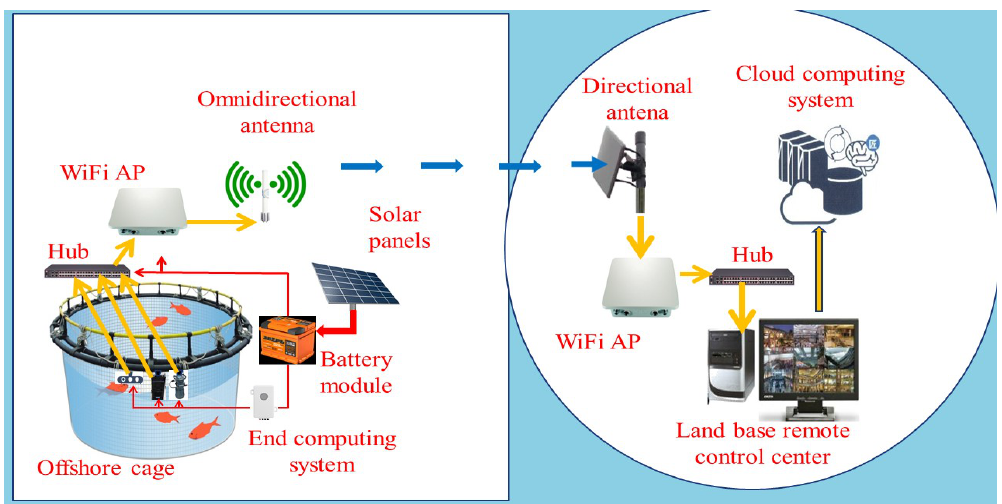
Figure 1. The proposed AIoT based smart cage system using multi-mode sensors include a stereo camera, a sonar imaging camera, and a set of water quality detectors. The time series data of each sensor device are first processed by the associate end computing system and sent to the cloud platform which offers all the AI micro-service computing for precise